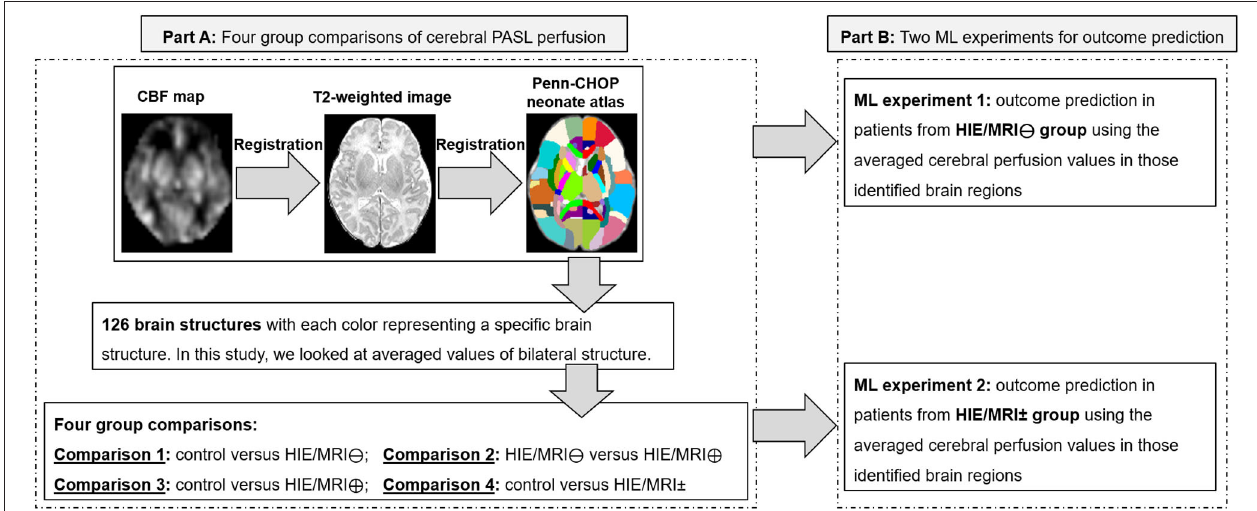
FIGURE 1 | Flow chart of the processing method. Part A: Four group comparisons of cerebral PASL perfusion. Part B: Two ML experiments for outcome prediction. In Part B, the ML experiment was not performed in patients from the HIE/MRI ⊕ group separately due to limited patients having long-term outcomes in this group. ML, machine